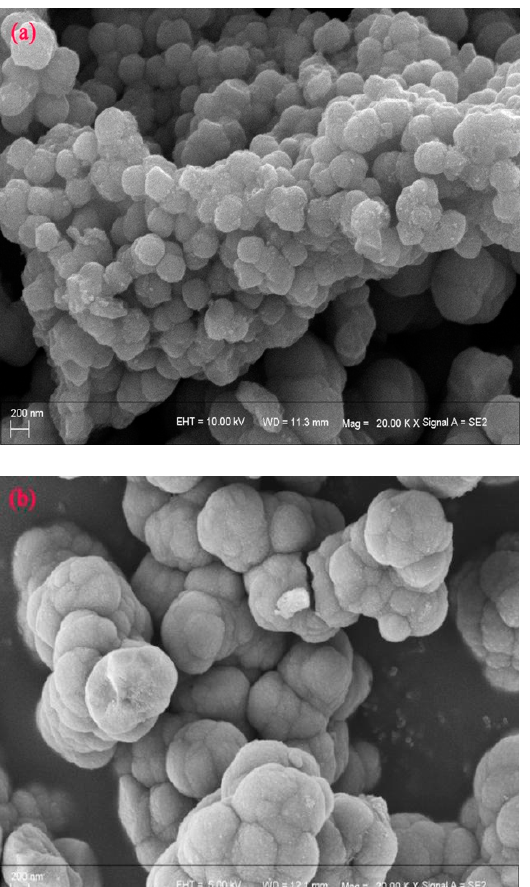
Figure 5. Influence of reaction time on precipitation extents.